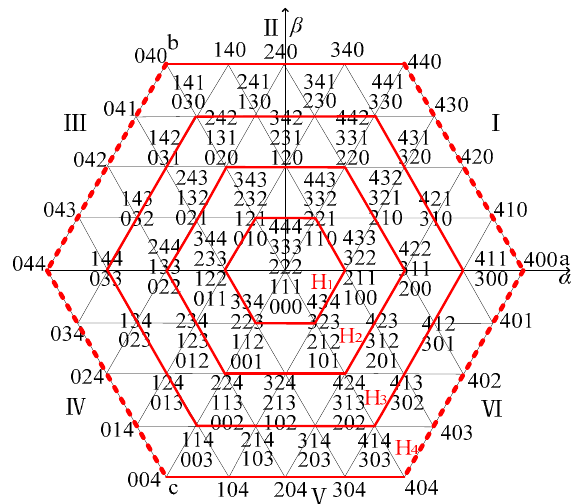
Figure 4. Voltage space vector diagram with one unit fault in phase A.